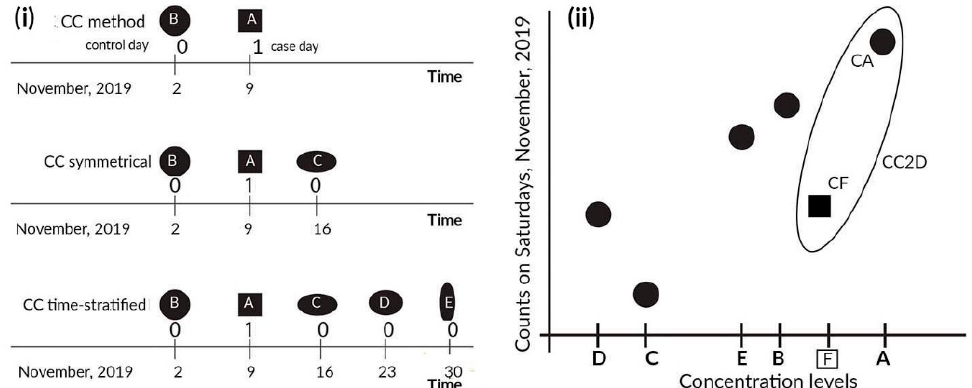
Figure 1. Left panel ( i ) shows variants of the case-crossover (CC) methods, with three control schemes { − 7,0}, { − 7,0,7}, and { − 7,0,7,14,21}, where 0 is an event day, − 7 is one week before event, 7 is one week after event, etc. Thus, { − 7,0} results in two days; 9 November as an event day and 2 November as a control day. Right panel ( ii ) shows the points used in the realization of the time-stratified CC methods with counts (the CCM method, which has hierarchical clusters of the form <year: month: day of week>). The exposure levels are A–E and can be lagged. The CC2D method (the method that uses the hierarchical calendar structure of <year: two days>) for just one pair—(A, CA), (F, CF)—is shown in the ellipsis; exposures A and F result in counts CA and CF, respectively.